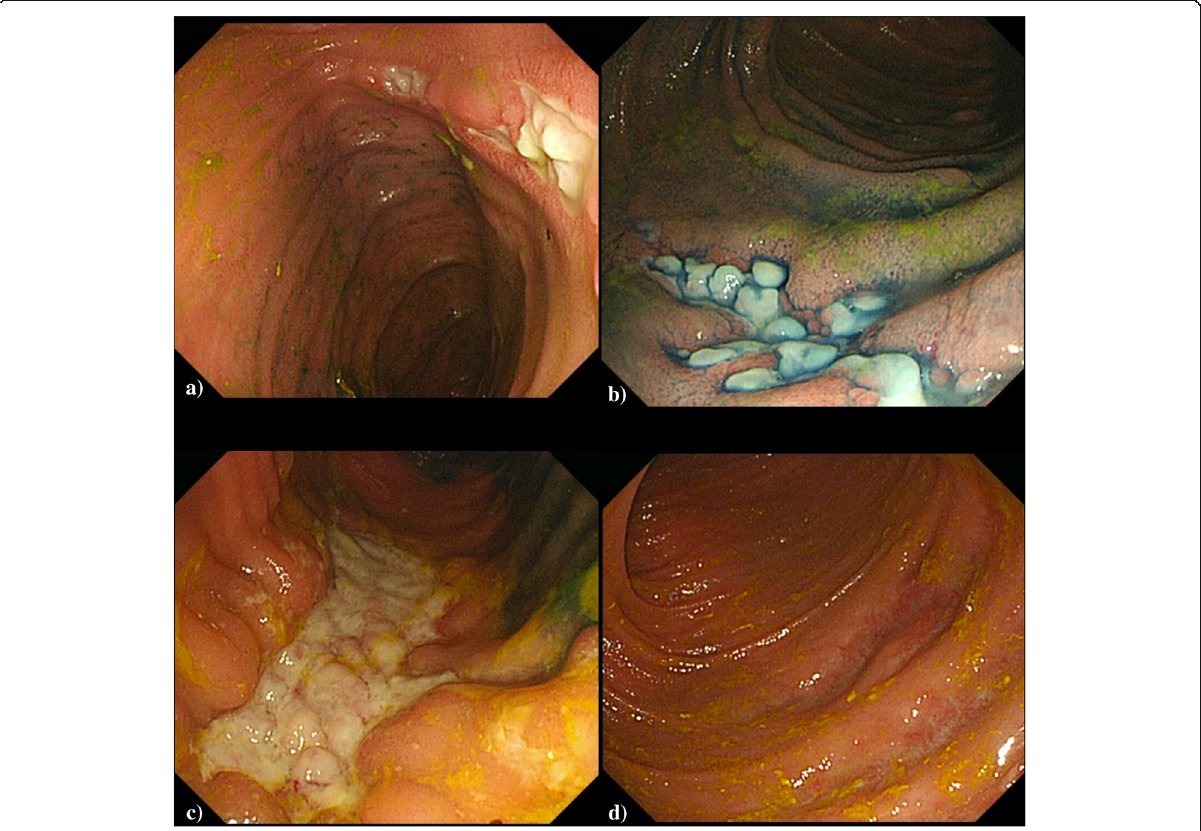
Fig. 8 a , b Postoperative endoscopic examination showed annular ulcers in the ileum in POD 55th. c A longitudinal ulcers in the ileum in POD 77th. d After administration of infliximab, ulcers healed rapidly in